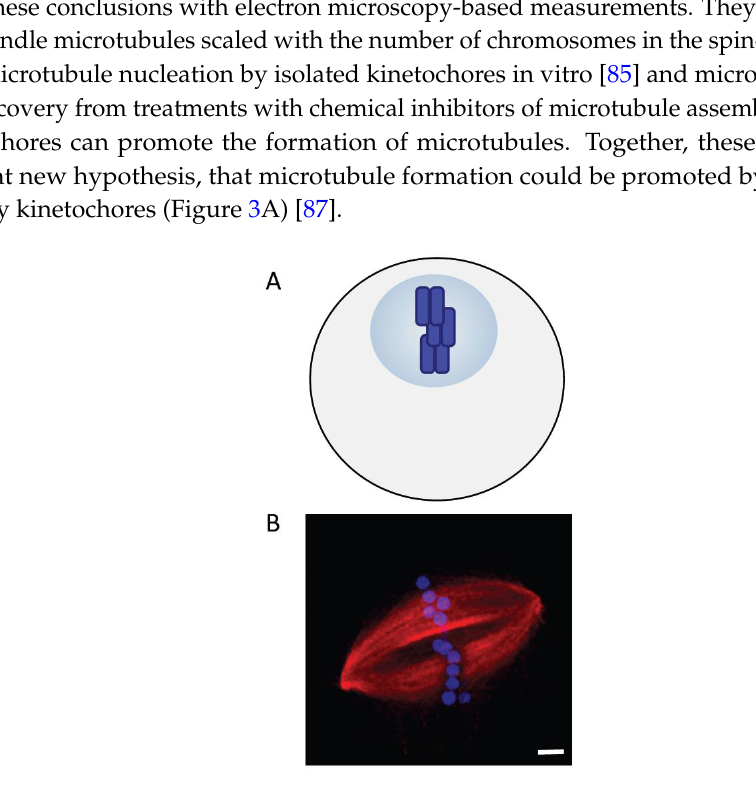
Figure 3. ( A ) Chromosomes (blue) generate signals to promote the formation of microtubules in their vicinity; ( B ) A spindle assembled around chromatinized DNA-beads added to Xenopus egg extracts. DNA: blue; tubulin: red. Scale bar, 5 μm.